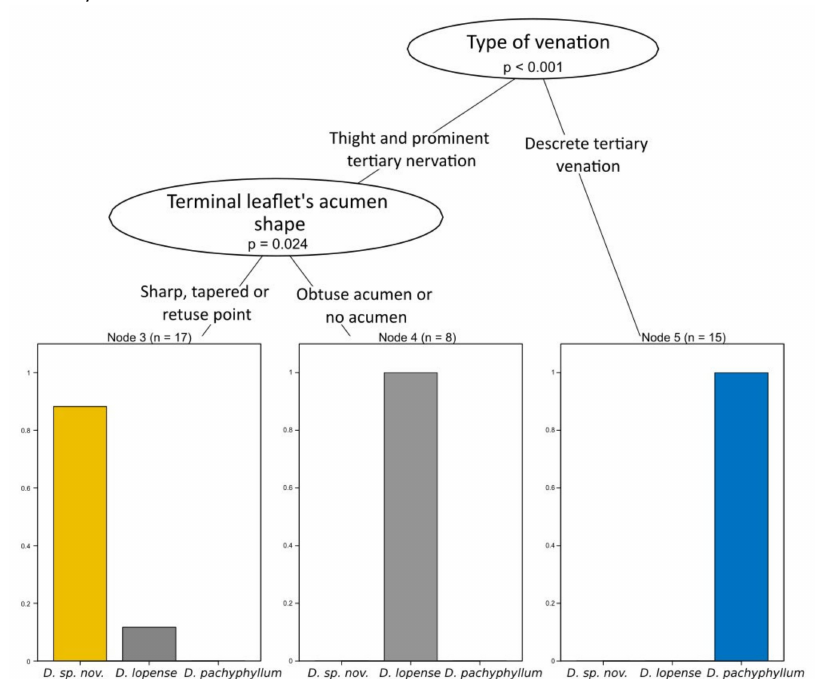
Figure 2. Conditional inference tree using the 25 leaf morphological variables to discriminate the 40 individuals for which all leaf traits could be